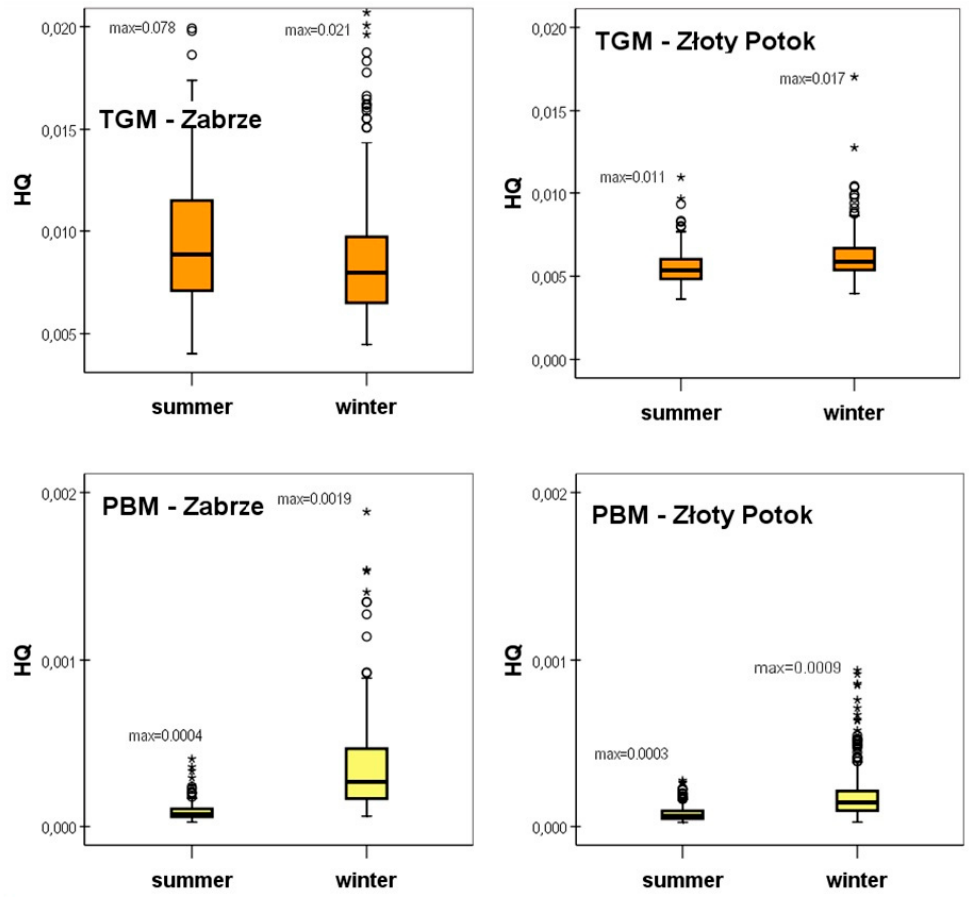
Figure 5. Seasonal distributions of hazard quotients (HQ) for total gaseous mercury (TGM) and PM 2.5 -bound mercury (PBM) in Zabrze (urban background) and Z ł oty Potok (rural background), in the period of 2014–2015.